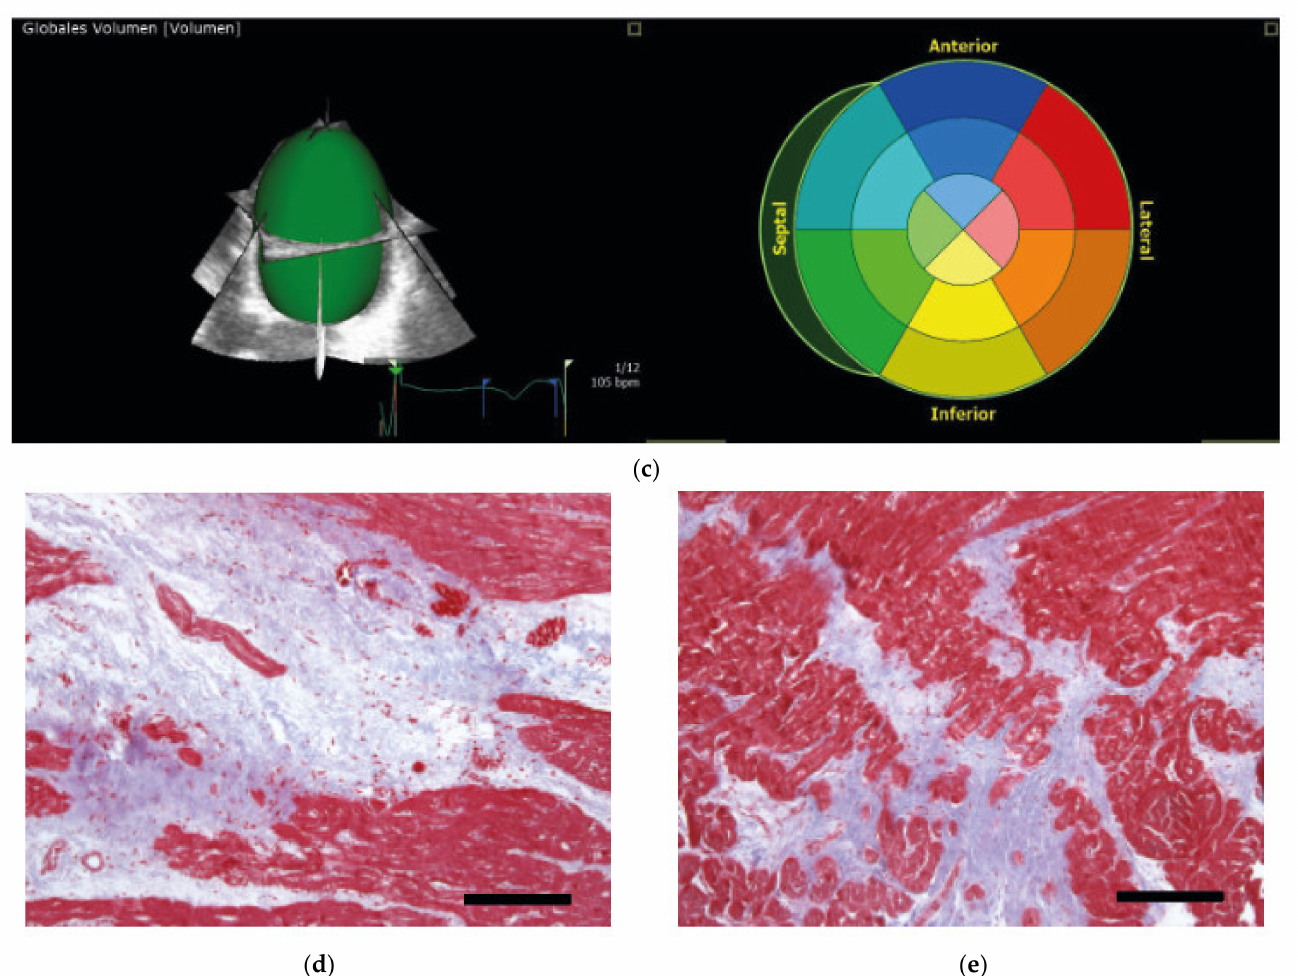
Figure 2. Echocardiographic data of the index patient under clinical deterioration before VAD therapy ( a – c ) and histochemical analysis of the explanted heart ( d , e ). ( a ) Four-chamber view showing the dilated left ventricle (LV) with intracavitary thrombotic material (red arrows). ( b ) Deformation analysis of global longitudinal strain values using 2D speckle tracking imaging with markedly impaired left ventricular average strain of–7.8%. ( c ) 3D-echocardiography of a LV full-volume dataset using Tomtec LV-Analysis 3 for volumetric assessment. The LV is enlarged more than twice the normal size (end-diastolic volume = 294.6 mL and end-diastolic volume index = 181.0 mL/m 2 ) with a reduced ejection fraction of 20.7%. ( d , e ) Masson’s trichrome staining of myocardial tissue obtained from the explanted heart. Pronounced interstitial fibrosis is observed in the left ( d ) and the right ( e ) ventricles. Scale bars = 200 µ